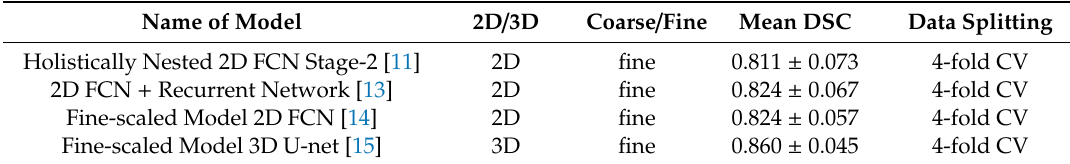
Table A1. Summary of fine-scaled models using Pancreas-CT